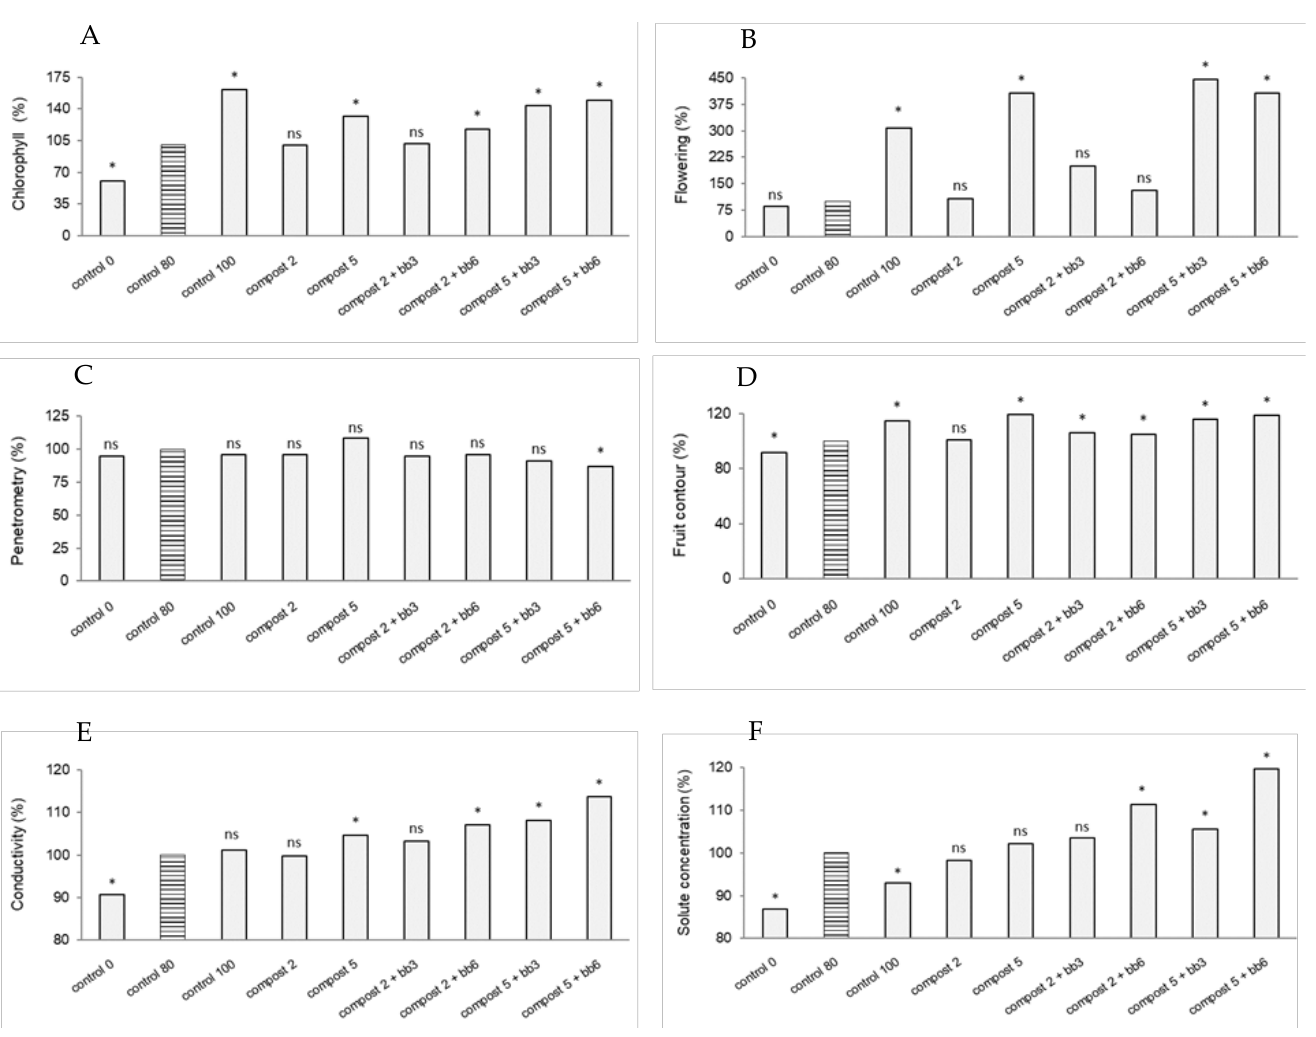
Figure 3. Response of other variables to the treatments applied in the field trial for the melon crop. The chlorophyll ( A ), the flowering ( B ), the penetrometry ( C ), the fruit contour ( D ), the conductivity ( E ), the solute concentration ( F ).The values are expressed as relative values in percentage, using, as a reference (100%), control 80. Comparison against control 80 was performed with the Dunnett test (* p ≤ 0.05, ns not significant). Table 4. ANOVA for chlorophyll content, flowering and several fruit parameters, in the melon crop. The location, the year and the plot were considered random factors, whilst the compost dose and the additive (PGPR + biochar) were fixed factors (significance level: *** p ≤ 0.001; ns, not